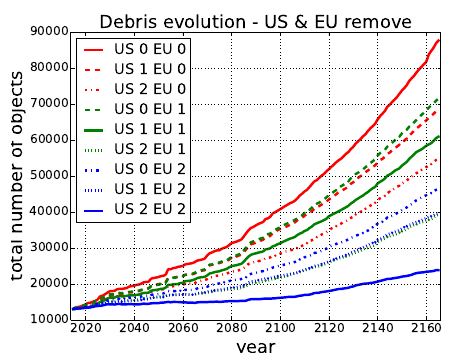
Figure 4. Debris evolution for next 150 years.